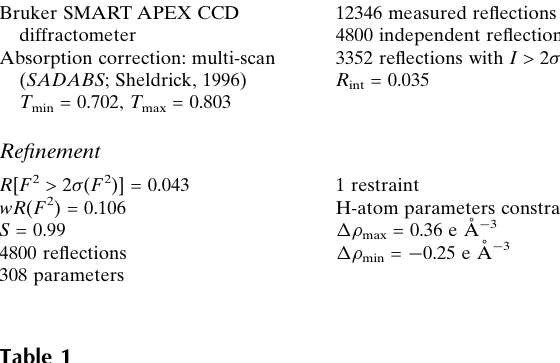
Selected geometric parameters (A˚ , (cid:2) ).